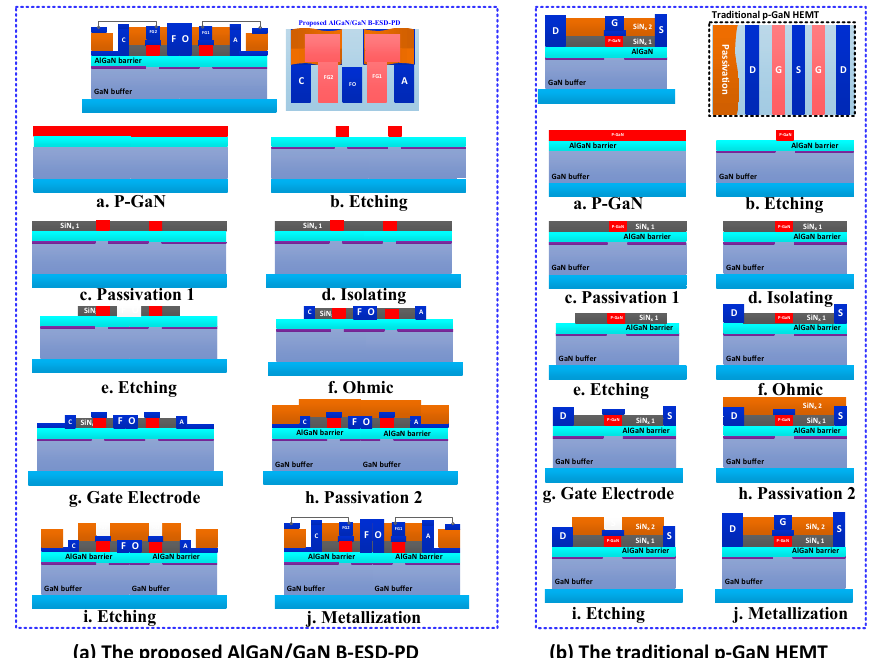
Figure 2. The possible fabrication process of ( a ) the proposed AlGaN/GaN B-ESD-PD and ( b ) traditional p-GaN HEMT.